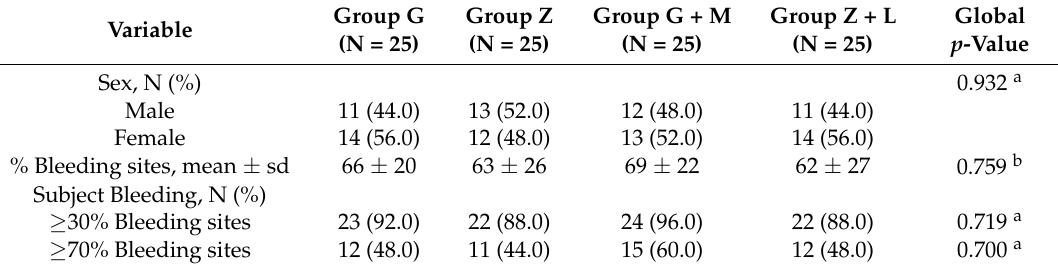
Table 1. Distribution of subject characteristics at baseline (n =